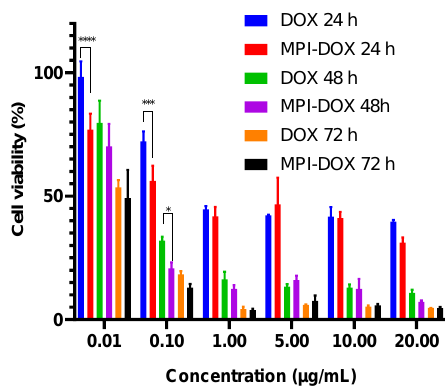
Figure 6. Cell viability % (MTT assay) of free doxorubicin and MPI-doxorubicin at doxorubicin or equivalent concentrations of 0.01, 0.1, 1, 5, 10, 20 mg / mL; free doxorubicin and MPI-doxorubicin on HCT 116 human colon cancer cells with 24, 48, and 72 h incubation time. The results are reported as mean ± SD ( n = 4), * P < 0.05, *** P < 0.001 and **** P < 0.0001 (two-way or one-way ANOVA, Tukey’s test).